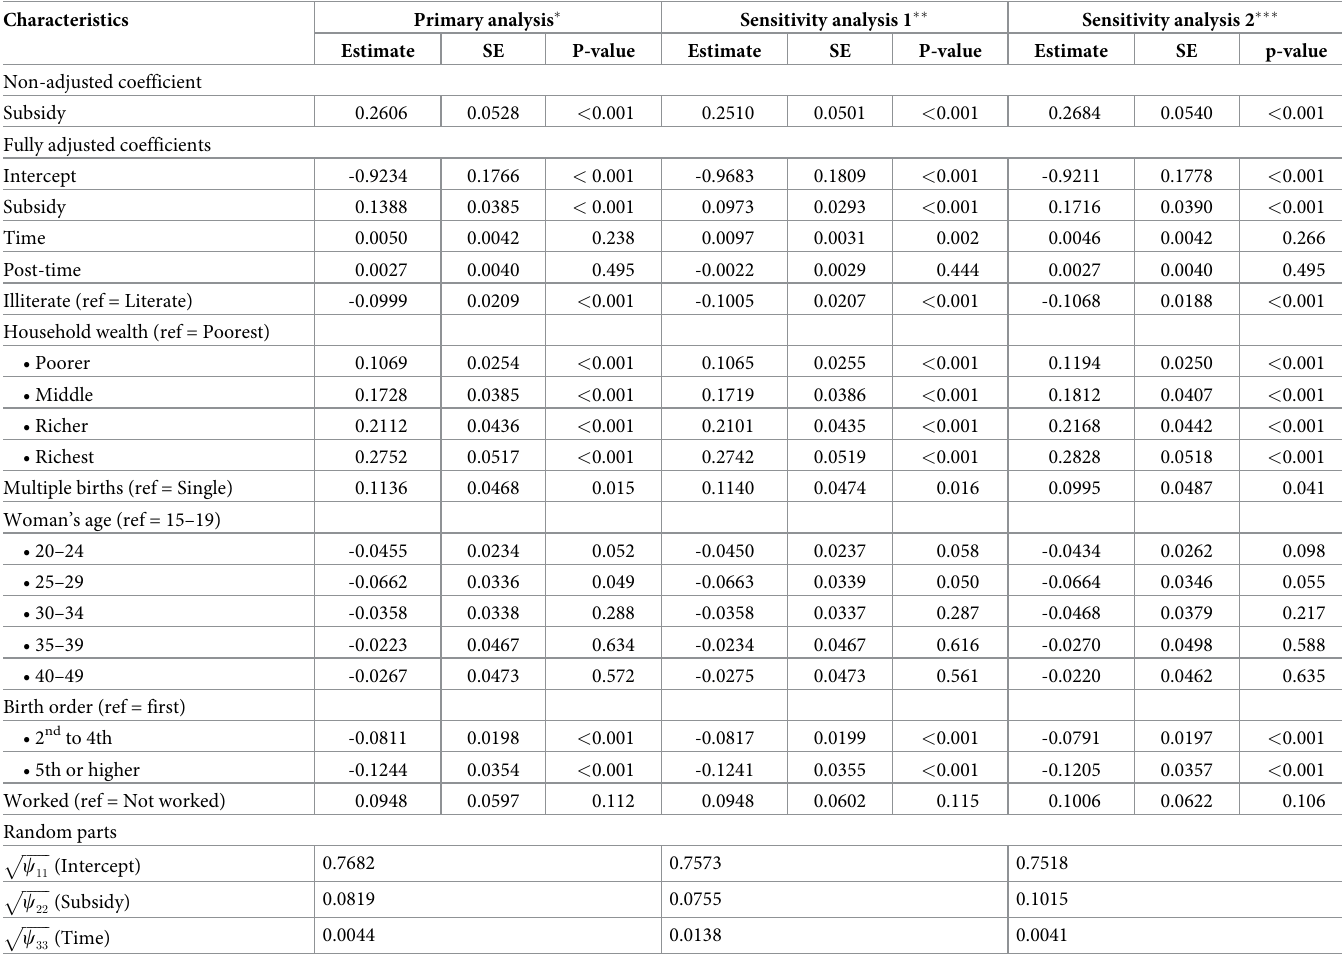
Table 2. Estimates for different two-level Random-coefficient (RC) Poisson regression models for the effects of the national subsidy on birth attendance in a health facility in rural Burkina Faso (Demographic and Health Survey